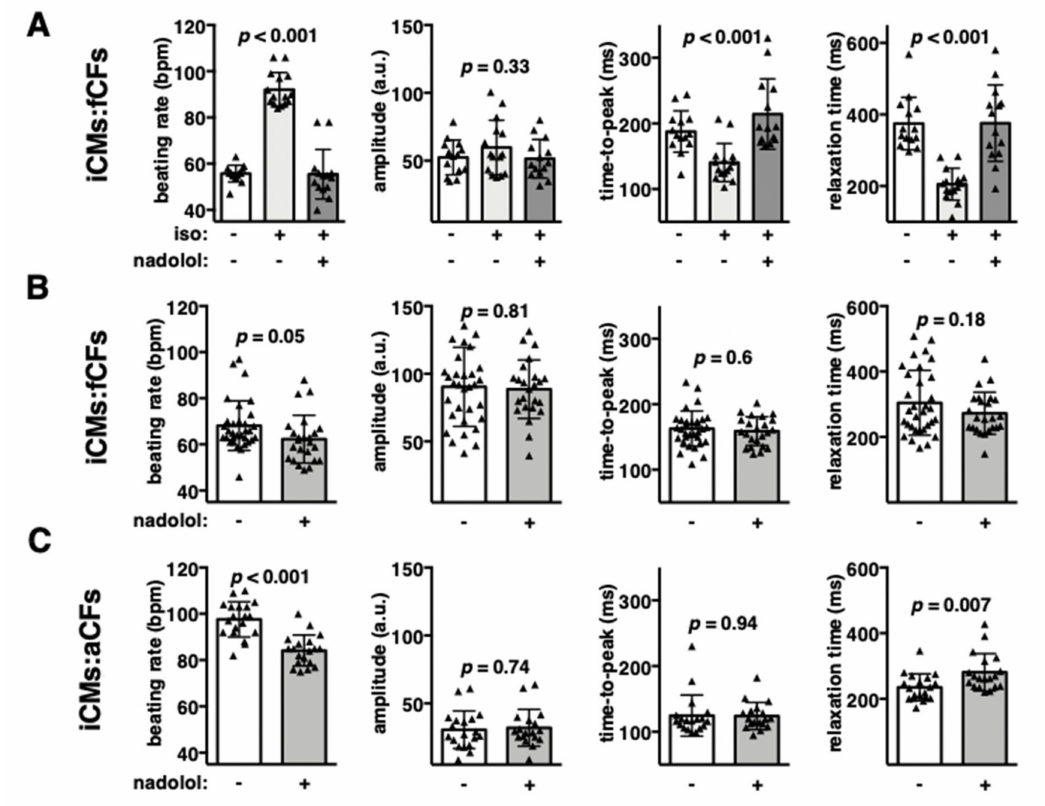
Figure 7. β -adrenergic receptor signalling in cardiac microtissues. Panel ( A ) shows quantification of contraction parameters of iCMs:fCFs microtissues stimulated with β -adrenoceptor agonist isoproterenol (iso, 10 nM) in the presence or absence of β -adrenoceptor blocker nadolol (1 µ M). Unstimulated microtissues were used as controls. Graphs in panels ( B , C ) show contraction parameters of iCMs:fCFs ( B ) and iCMs:aCFs ( C ) microtissues treated with vehicle or 1 µ M nadolol in the absence of isoproterenol. Each triangle represents data for one microtissue. p values were calculated with ANOVA for ( A ) and with the Student’s t -test for ( B , C